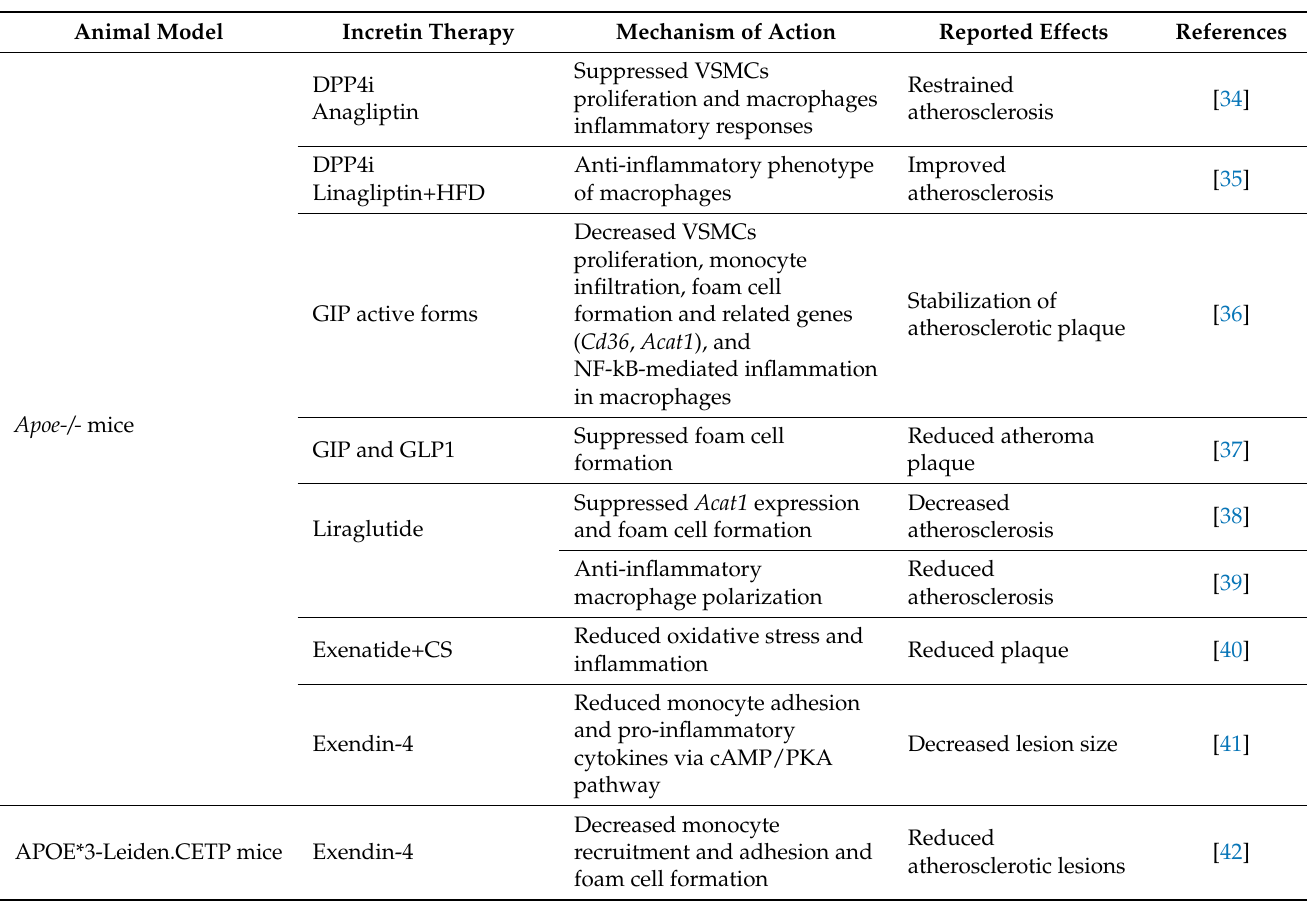
Table 1. Preclinical studies of incretin-based therapies in animal models of atherosclerosis, vascular injury, and myocar- dial